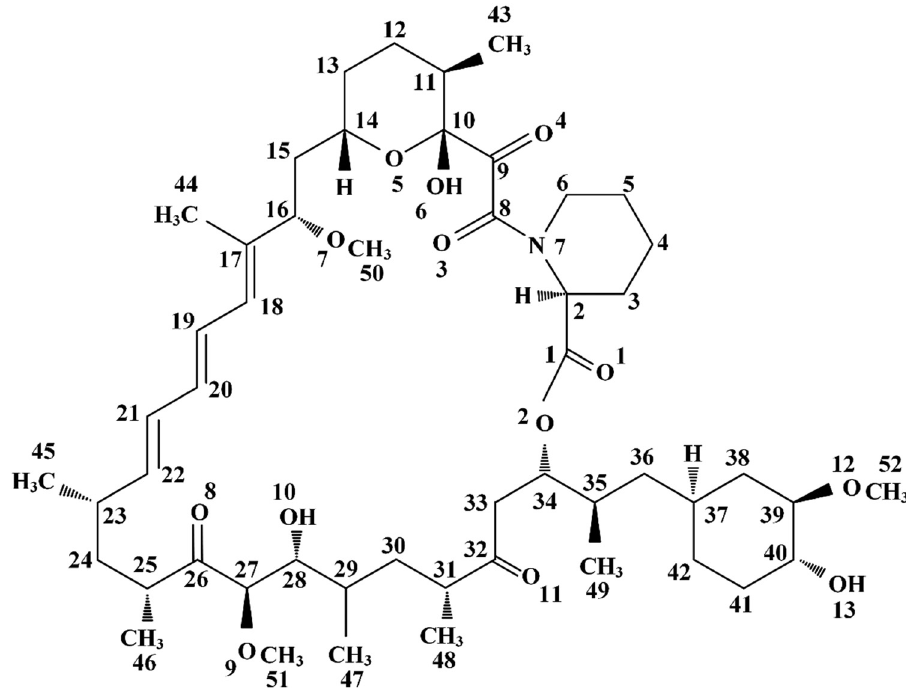
Figure 5: The structure of rapamycin [ 32 ] .